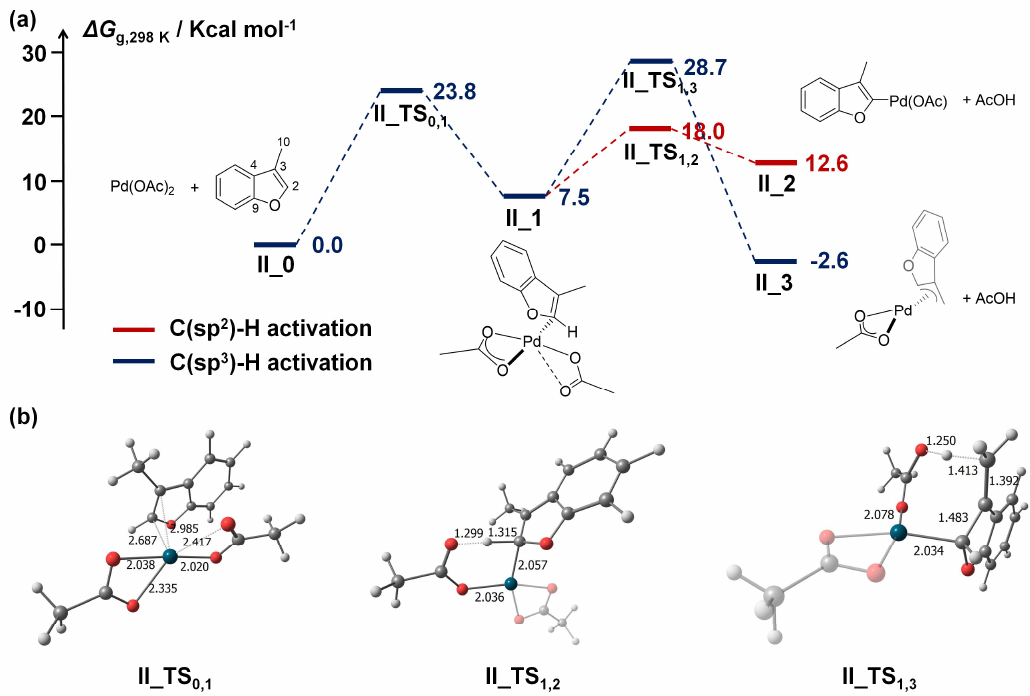
Figure 3. ( a ) Free energy reaction profile for C(sp 2 )−H (red) and C(sp 3 )−H (blue) activation by II . Numbers are Δ G in water at 298 °C (energies in kcal/mol). ( b ) Optimized geometries of transition states with selected bond lengths (Å). The spectator acetate group is drawn translucent for clarity.